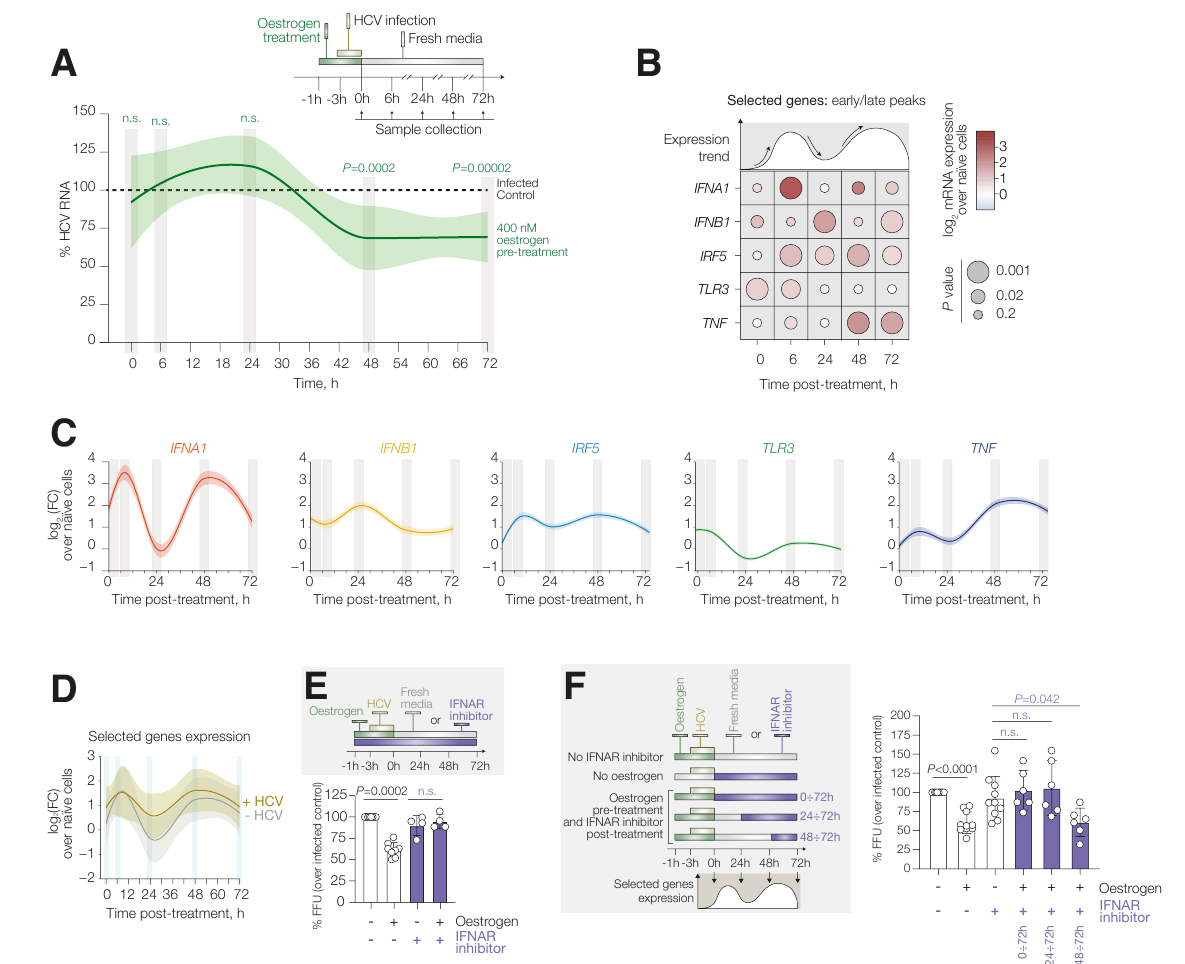
Figure 3. E2-mediated antiviral effect is type I interferon dependent and not affected by viral replication. HuH7 cells were treated with 17 β -oestradiol or DMSO (infected control) for 1 h, followed by infection in the presence of inhibitor treatment. HCV RNA quantification and gene expression analysis were performed as indicated. ( A ) Intracellular HCV RNA (%) of oestrogen-treated cells relative to infected and untreated control (dashed line). Data represent the mean of at least 3 independent experiments with 2 biological replicates. Statistical significance was evaluated by Mann–Whitney U test. ( B , C ) Bubble plot ( B ) or time-course gene expression ( C ) of the five genes. Data represent the mean mRNA fold change (log 2 (FC)) in oestrogen-treated and infected cells normalised and compared to naïve cells. Data are derived from at least 3 independent experiments with 2 biological replicates. Statistical significance was evaluated by multiple t -tests with Bonferroni correction. ( D ) Time-course gene expression comparison of the 5-gene set between oestrogen-treated cells with or without HCV infection. Data represent the mean mRNA fold change (log 2 (FC)) in oestrogen-treated cells, with or without infection, normalised to naïve cells. Data are derived from at least 3 independent experiments with 2 biological replicates. Statistical significance was evaluated by Wilcoxon signed-rank test. ( E , F ) HuH7 cells were treated with 17 β -oestradiol for 1 h, followed by infection in the presence of oestrogen. IFNAR inhibitor was added for the entire duration of the experiment ( E ) or added at different time points post infection (0 ÷ 72 h, 24 ÷ 72 h and 48 ÷ 72 h) ( F ). FFU assay were performed at 72 h post infection and results were normalised to untreated control cells. Data represent the mean and SEM of at least 3 independent experiments with 2 biological replicates. Statistical significance was evaluated by Mann–Whitney U test. n.s.: not